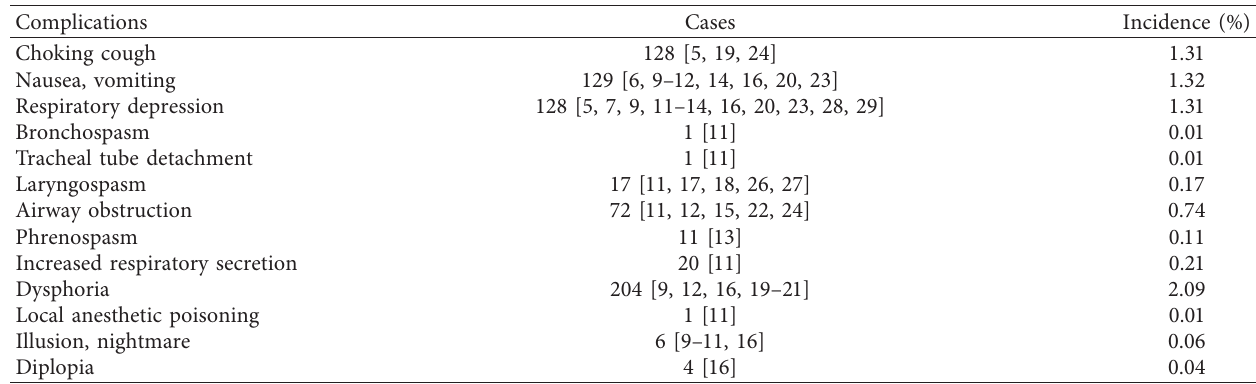
Table 4: Anesthesia-related complications.